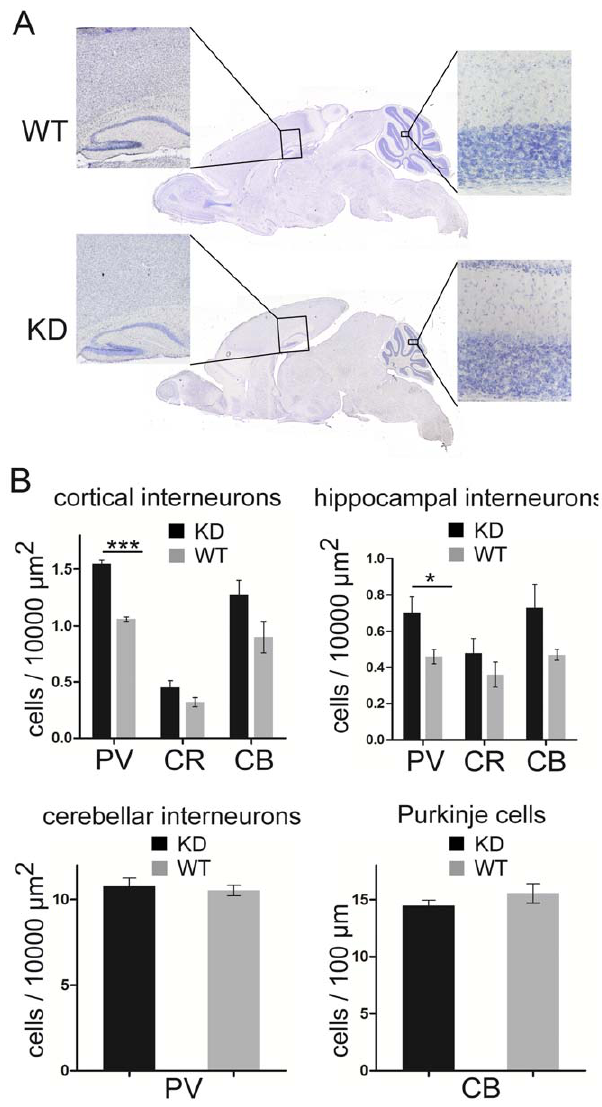
Figure 3. Normal brain architecture in c 2 KD mice. A, Nissl staining reveals a similar morphology in the brain of a c 2 KD mouse and a WT littermate. B, Quantitative analysis based on immunofluorescence labeling using antibodies against calcium binding proteins. The density of parvalbumin (PV)-positive cells in the hippocampal CA1 and sensorimotor cortex of c 2 KD mice was significantly increased with respect to WT (***, p , 0.0001; *, p=0.0352; unpaired t -test; n=4 mice per group). The density of MLIs and PCs in the cerebellum was unaltered (MLIs, p=0.6653; PCs, p=0.3224; unpaired t -test; n=5 mice per group). CB, calbindin; CR,